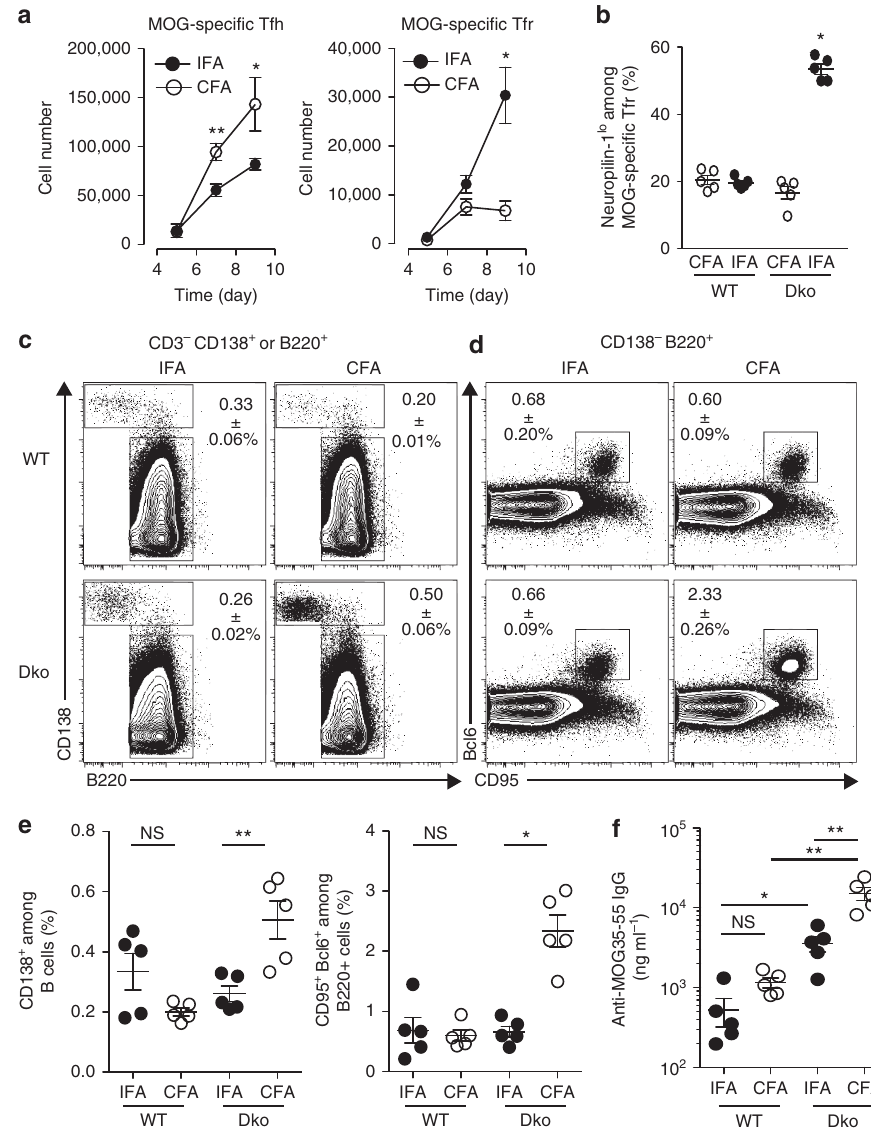
Figure 2 | Immunization with MOG in IFA induces increased numbers of Tfr cells that are Neuropilin-1 lo . Dko mice were immunized with MOG35-55 emulsified in CFA or IFA. ( a ) Absolute numbers of total MOG-specific Tfh cells and Tfr cells of Dko mice immunized with CFA (open circle, as in Fig. 1c) or IFA (solid circle) at indicated time in dLN. ( b ) Neuropilin-1 lo expression among MOG-specific Tfr cells 7 days after immunization of WTand Dko mice with MOG35-55 emulsified in CFA (white circles) or IFA (black circles). Data shown are from a single experiment (five mice per group) and are representative of three independent experiments. ( c ) CD138 and B220 staining of CD3 (cid:2) CD138 þ or B220 þ dLN cells (see Supplementary Fig. 4) from WTand Dko mice 12 days after immunization with MOG in IFA or CFA. ( d ) CD95 and Bcl6 staining of CD138 (cid:2) B220 þ cells. ( e ) Frequencies of total plasma cells and GC B cells of WTand Dko mice immunized with IFA (solid circle) and CFA (open circle) in dLN 12 days after MOG immunization. ( f ) Quantity of MOG-specific Ig in the sera of immunized WTand Dko mice estimated using ELISA 12 days after MOG immunization. Data shown are from a single experiment with five mice per group and are representative of two independent experiments. Data were analysed using the non-parametric Mann–Whitney test. ns, not significant, * P o 0.05, ** P o 0.01, mean ±